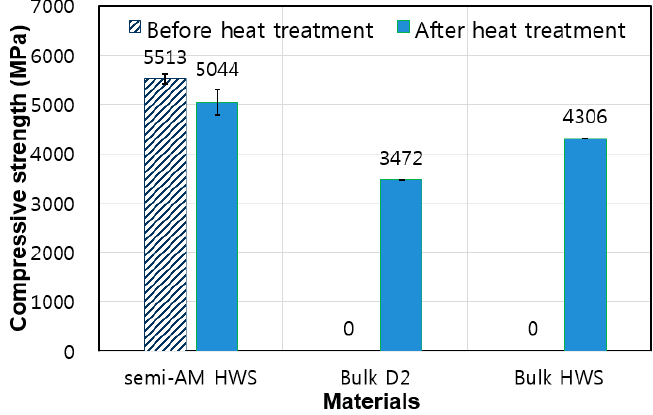
Figure 11. The compressive strength comparison of the three materials.